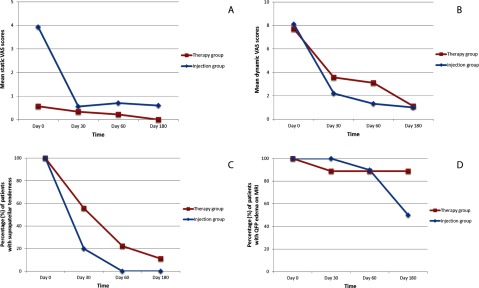
Graphs of timeline of clinical and radiological findings in study groups. Changes from baseline (a, b) in static and dynamic VAS scores. Changes from baseline (c) in presence of suprapatellar tenderness. Changes from baseline (d) in quadriceps fat pad (QFP) edema on MRI. Note that x-axes are not to scale; and y-axes on a and b represent mean VAS scores, while they denote percentage of patients with the presence of a condition on c and d.